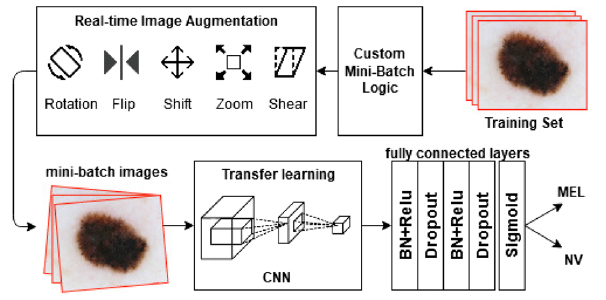
Figure 1. Proposed melanoma prediction system (this figure was created with